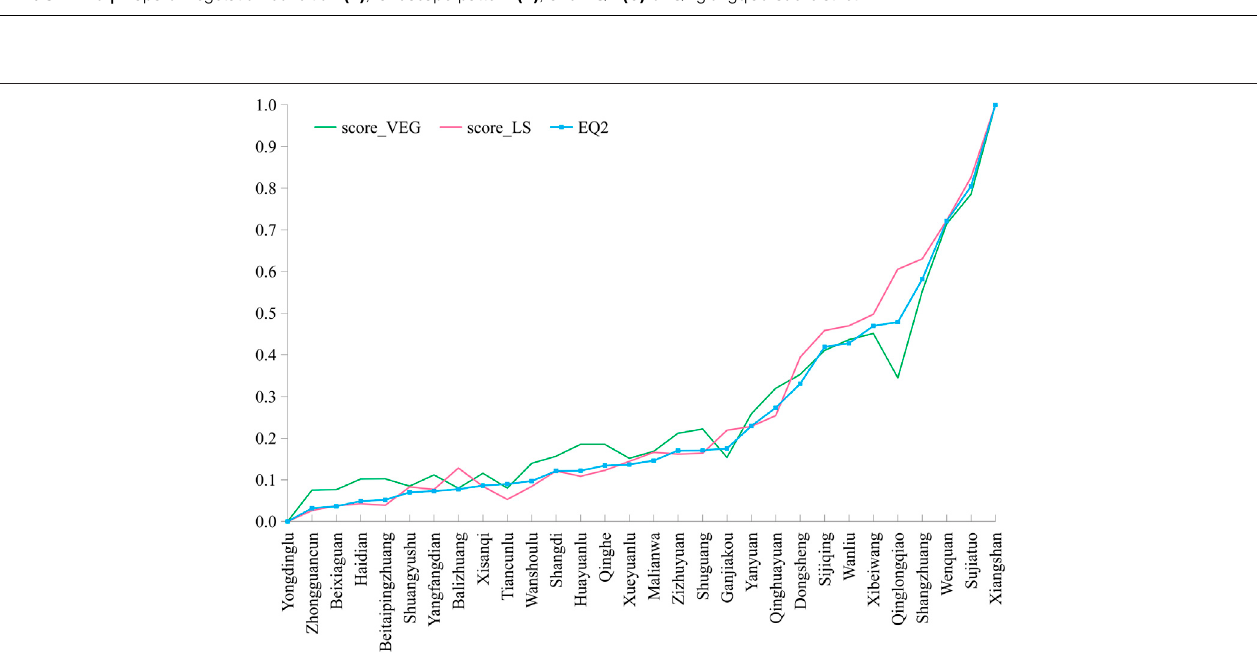
FIGURE 11 | The normalized results of landscape pattern levels, vegetation condition levels and ecological quality.